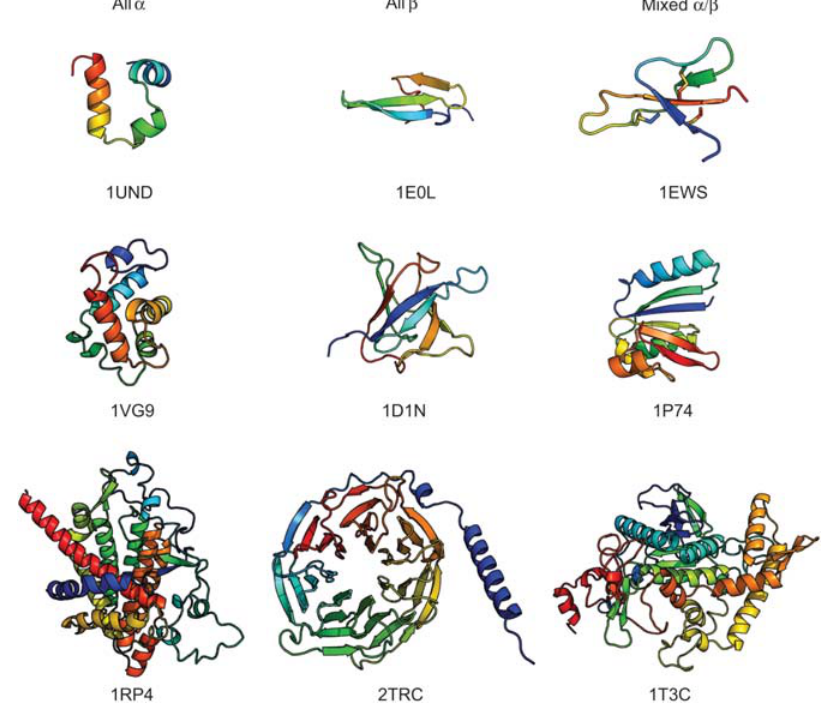
Figure 3 Examples of fold representatives of different structural class and size. From top to bottom, examples (including PDB code) are given of small ( - 50), medium ( G 50, - 150) and large ( G 150) representative protein domains. From left to right, different structural classes are depicted, as indicated.